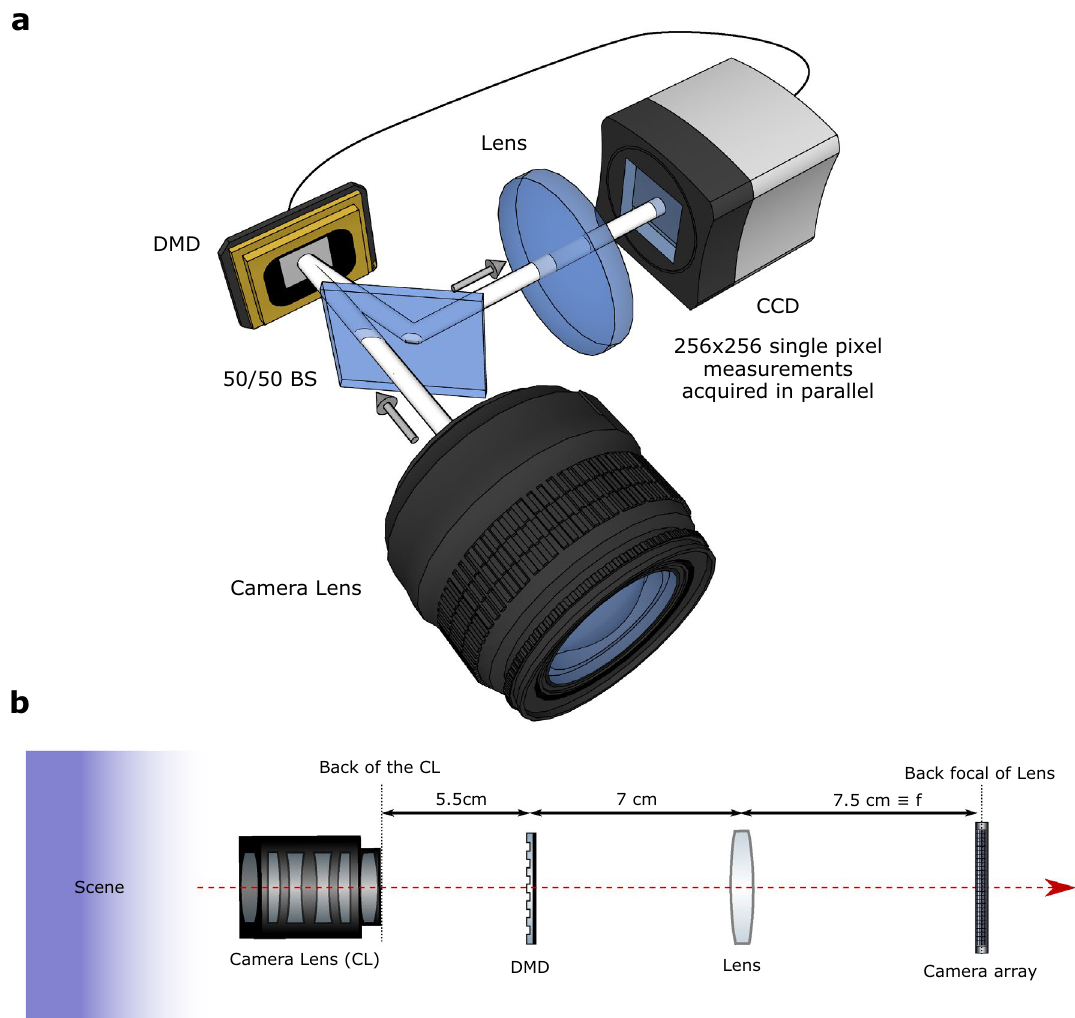
Figure 1. Computational light-field Imaging setup. A Camera lens is used to image a scene onto a Digital Micro-mirror Device (DMD), and that can perform a single pixel measurement on each pixels. The light reflected off the DMD pattern is then reflected by a 50/50 beamsplitter (BS) and sent onto a CCD camera set to image the spatial frequencies in the scene. By displaying Hadamard patterns on the DMD, and acquiring camera images for each displayed pattern, one can perform a single-pixel-like light-field. ( a ) 3D representation of the light-field camera with 50/50 BS allowing the use a DMD around normal incidence ( b ) unfolded optical configuration with the relative position of the various optical components along the optical axis. The DMD is here represented in transmission for simplicity and the BS is not